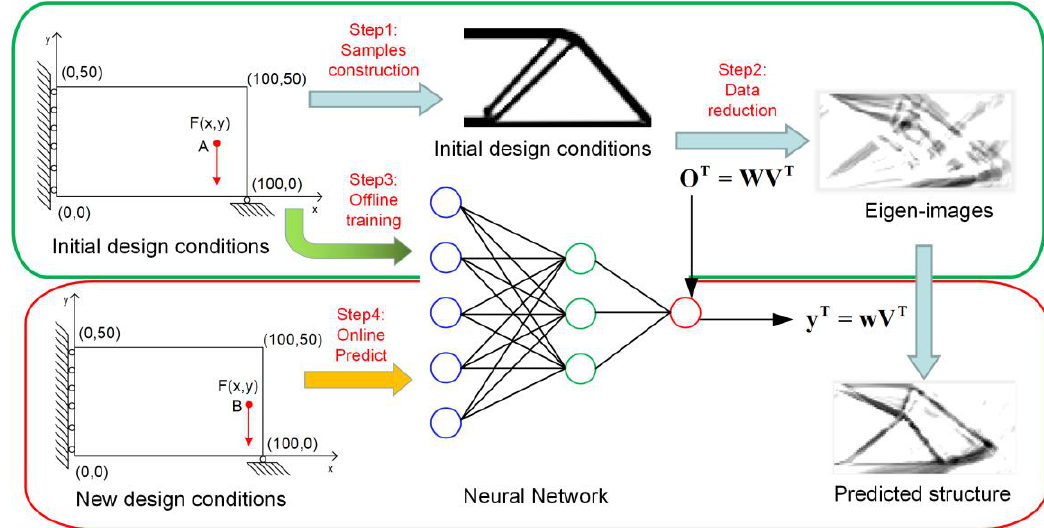
Figure 5. Process for real-time topology optimization implementation.